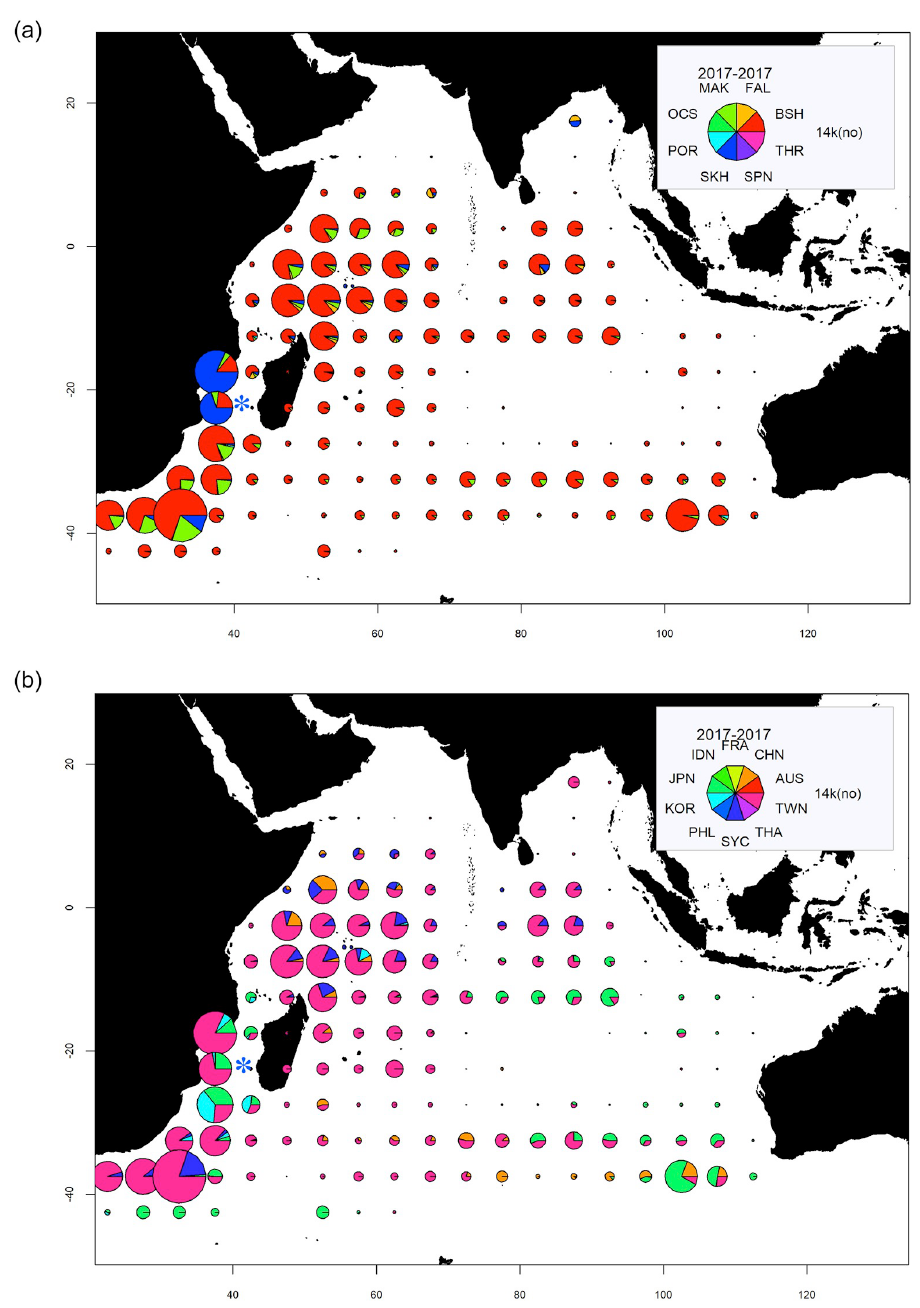
Fig 3. Maps showing the catches (total numbers) of sharks, by species and fleets in 2017 in the Indian Ocean. Reprinted from document IOTC -2018-WPEB14-07 under CC BY license, with permission from the Indian Ocean Tuna Commission, original copyright 2021. MAK: Isurus oxyrhynchus ; FAL: Carcharhinus falciformis ; BSH: Prionace glauca ; THR: Alopias spp.; SKH: non-identified sharks; POR: Lamna nasus ; OCS: Carcharhinus longimanus ; SPN: Sphyrna spp. FRA: European Union France; CHN: China; AUS: Australia; RWN: Taiwan Province of China; THA: Thailand; SYC: Seychelles; PHL: Philippines; KOR: South Korea; JPN: Japan; IDN: Indonesia. Blue star: study site.